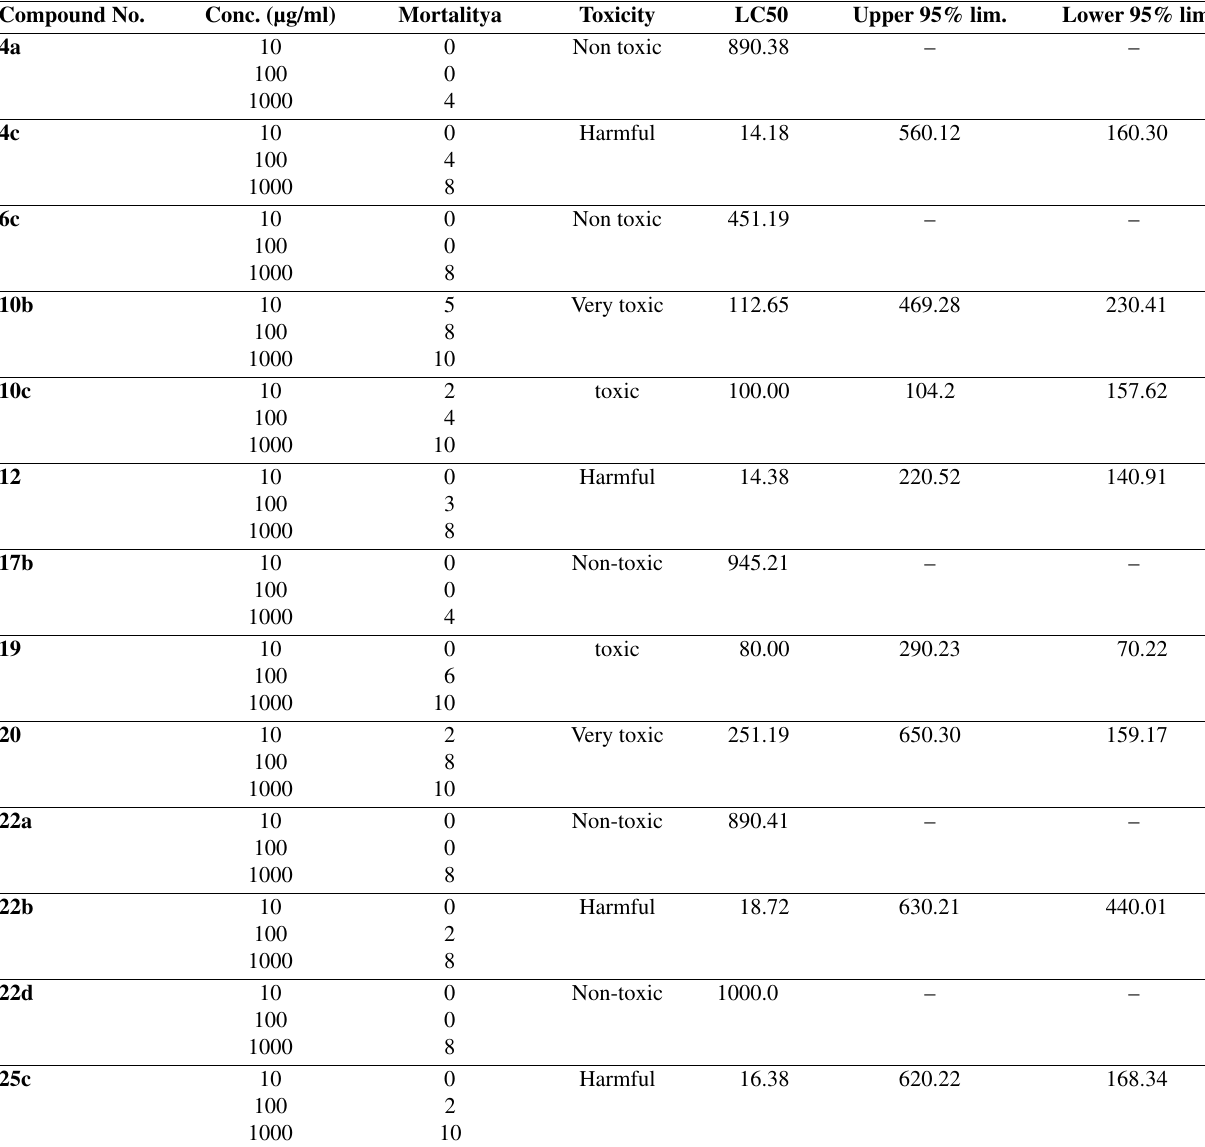
Table 2. Toxicity of the most optimal cytotoxic compounds against shrimp larvae Compound